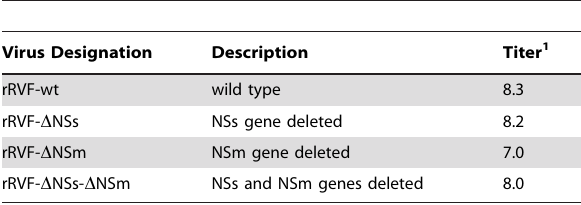
Table 1. Reverse genetics-generated RVF viruses used in this